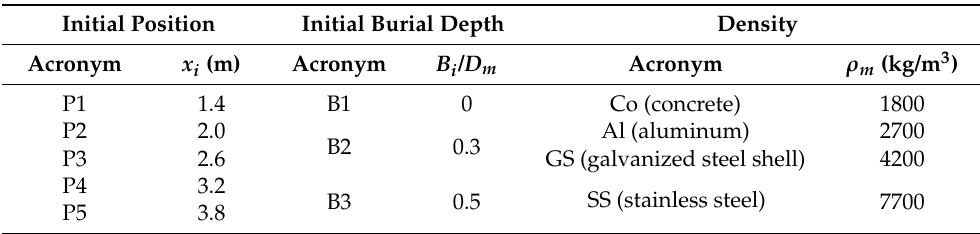
Table 2. Specifications of the objects deployed during the laboratory study and the options of initial position and burial depth.